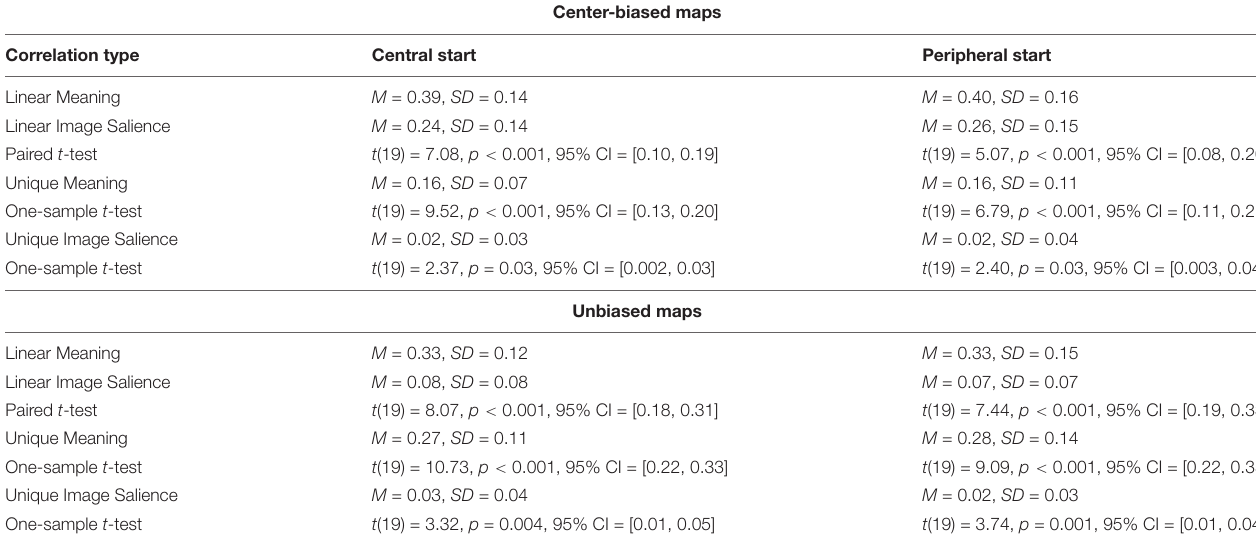
TABLE 1 | Comparison between central start and peripheral start experiments using the meaning and saliency maps to predict the overall pattern of attention. Center-biased